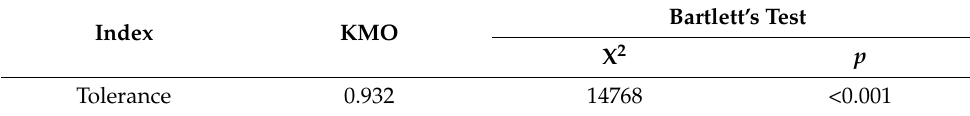
Table 2. Bartlett’s Test of